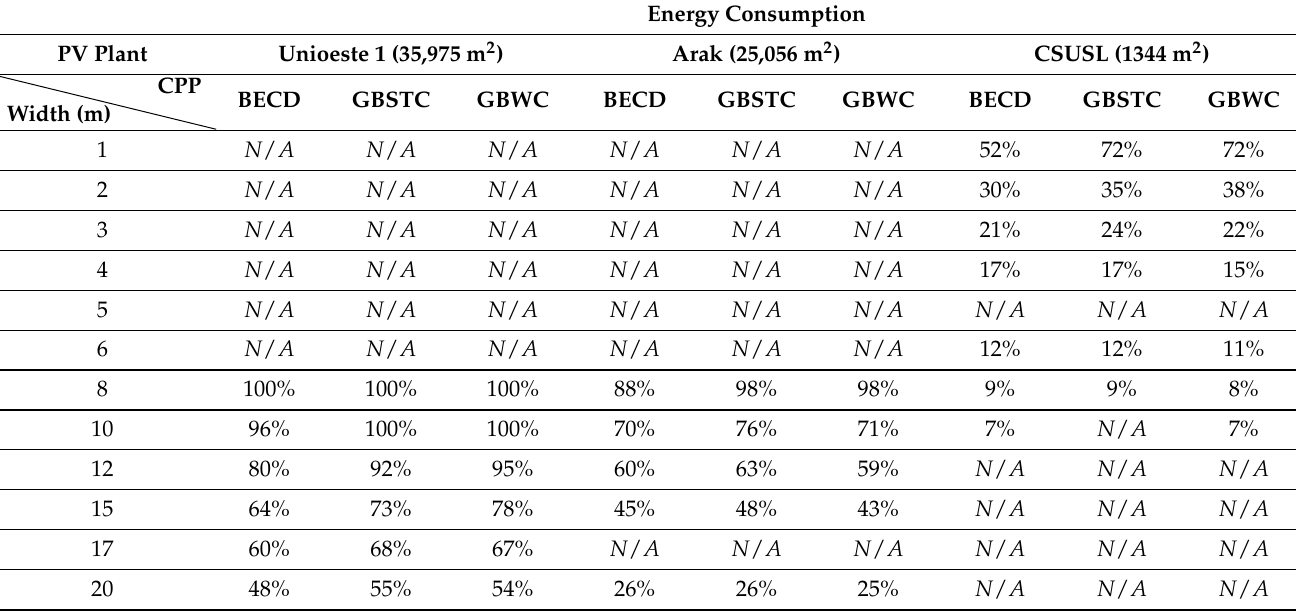
Energy Consumption